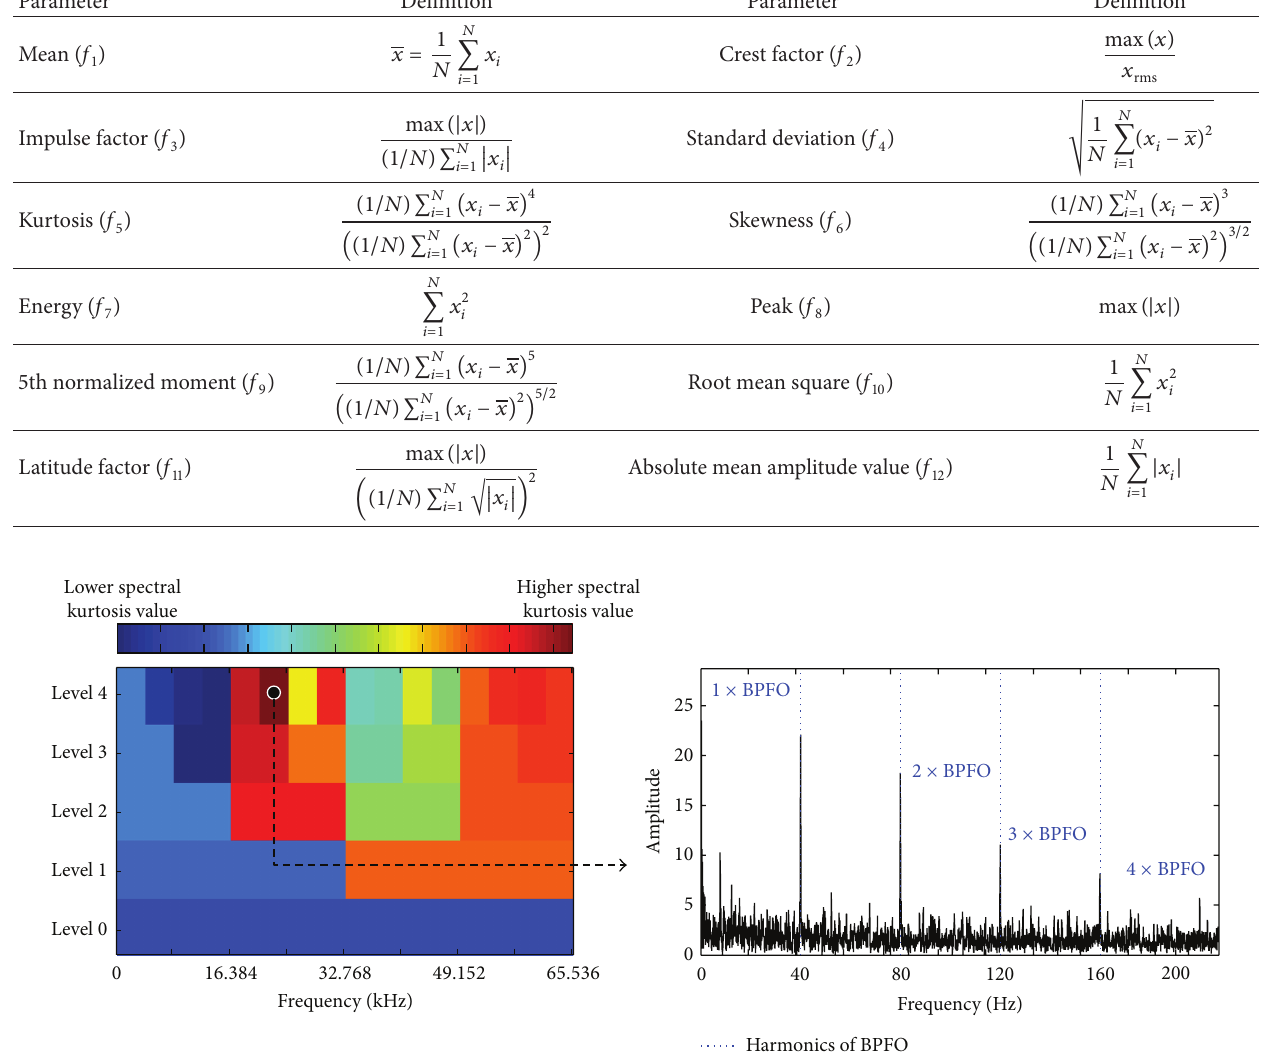
Figure 4: An example of spectral kurtosis analysis for a